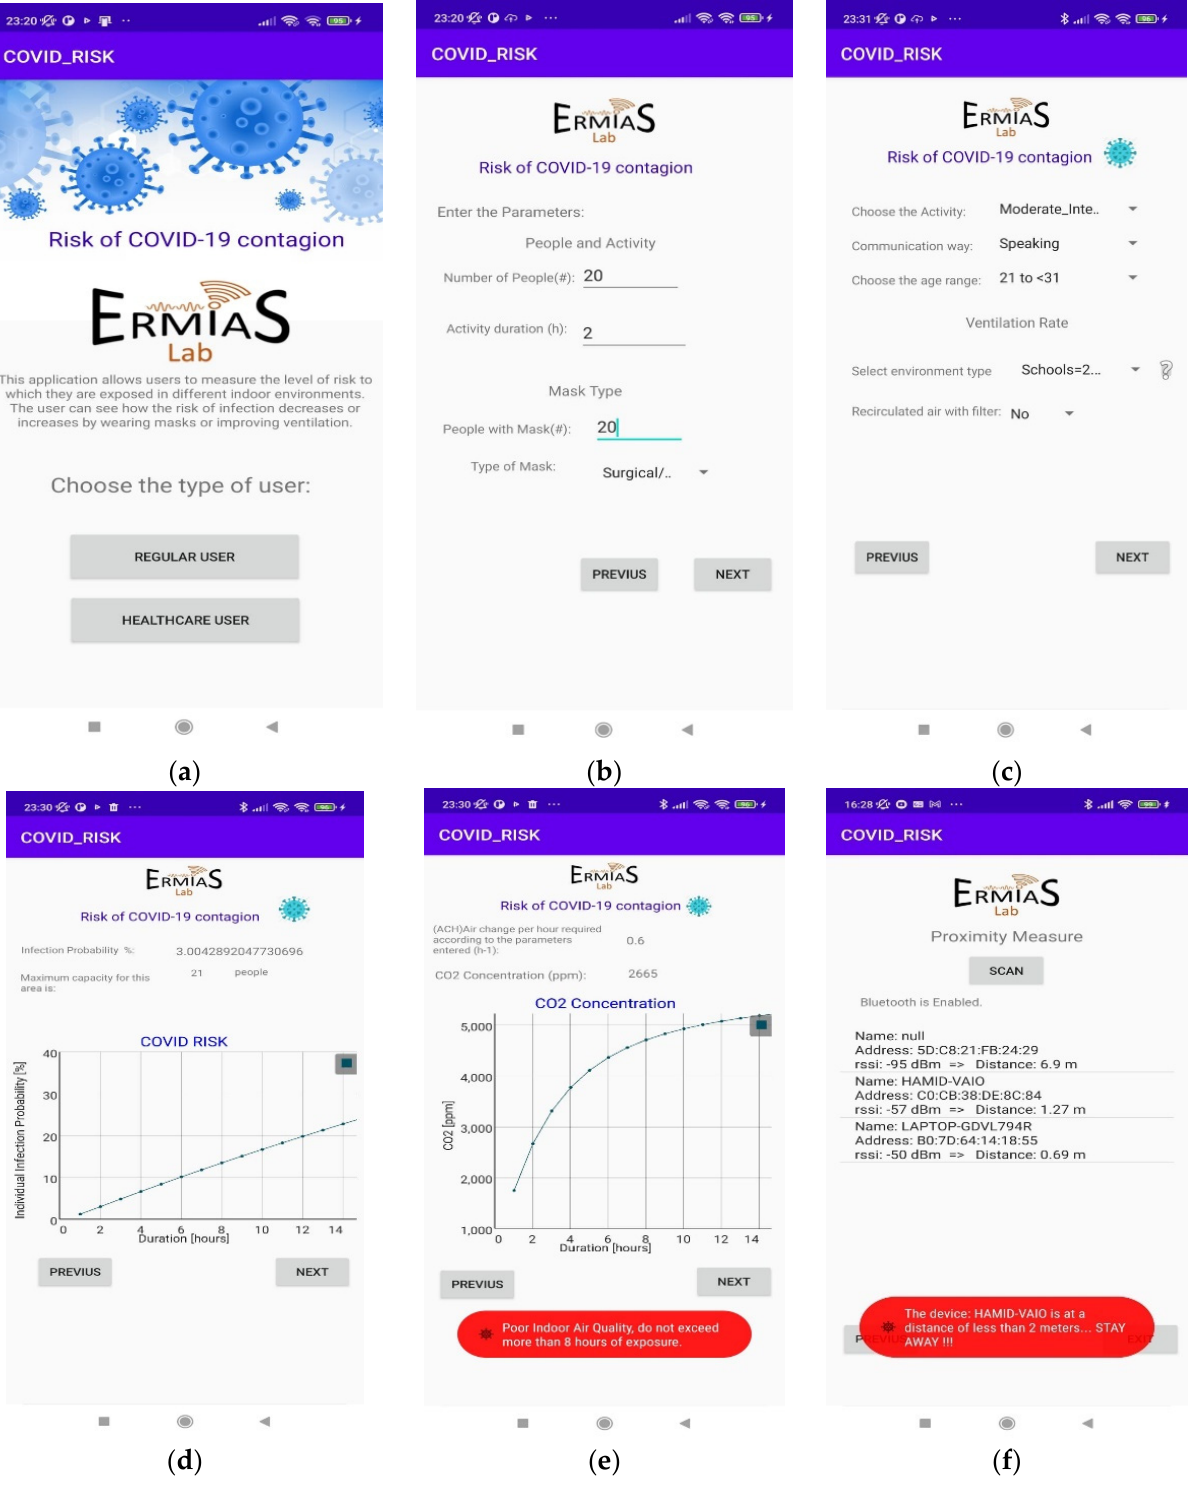
Figure 8. Android application results: ( a ) main screen of the application; ( b ) entry of parameters related to the type of people; ( c ) entry of parameters related to the type of environment; ( d ) proba- bility of infection with respect to permanence time and the maximum number of allowed people; ( e ) required Air Changes per Hour (ACH) and concentration of CO 2 ; ( f ) proximity meter.